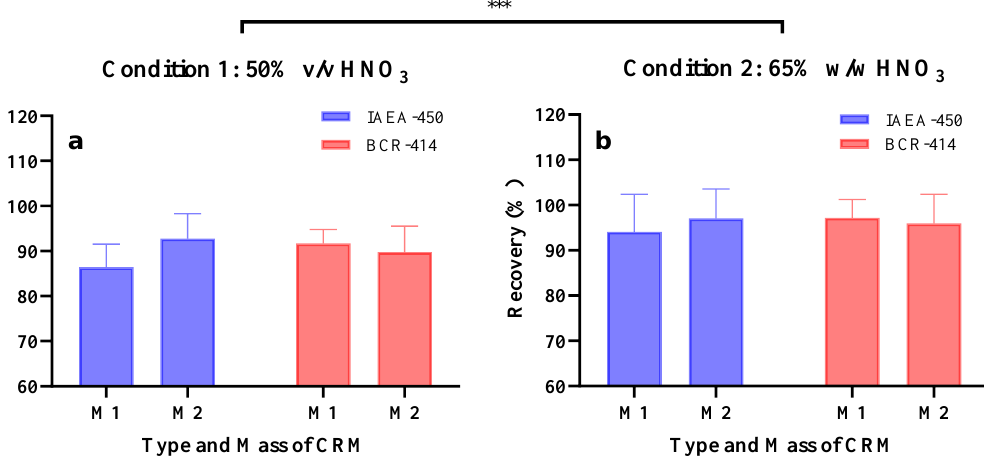
Figure 2. Recovery efficiency in percentage of ( a ) condition 1 and ( b ) condition 2 on the different conditions: CRM type: IAEA-450 and BCR-414, and different biomass: M1—3.1 ± 0.6 mg and M2—21.6 ± 1.5 mg. The error bar shows the standard deviation of the recovery values at different conditions. A two-way ANOVA was performed on the recoveries obtained between the digestion conditions and type of CRM used, with the two conditions tested being significantly different (*** p < 0.0005).